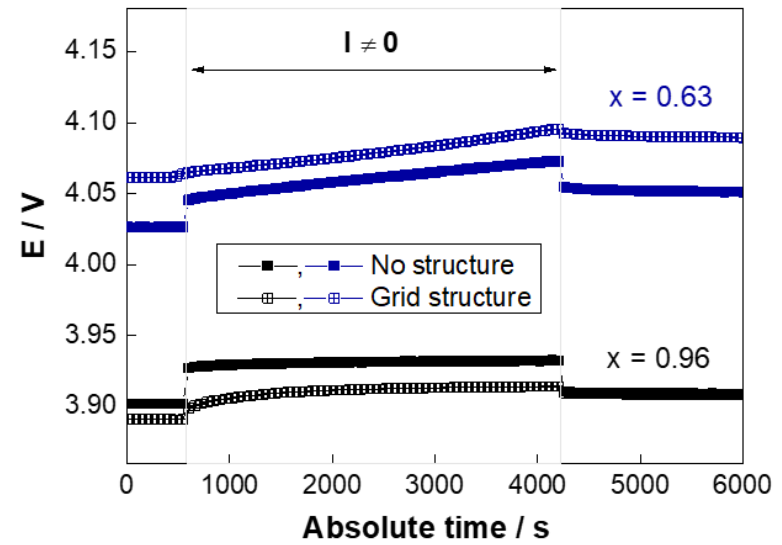
Figure 6. Measured current pulses during GITT from cells with structured (open symbols) and unstructured (solid symbols) electrodes at different state of charge, i.e., different lithium content x in cathode material (black: x = 0.96, blue x = 0.63).